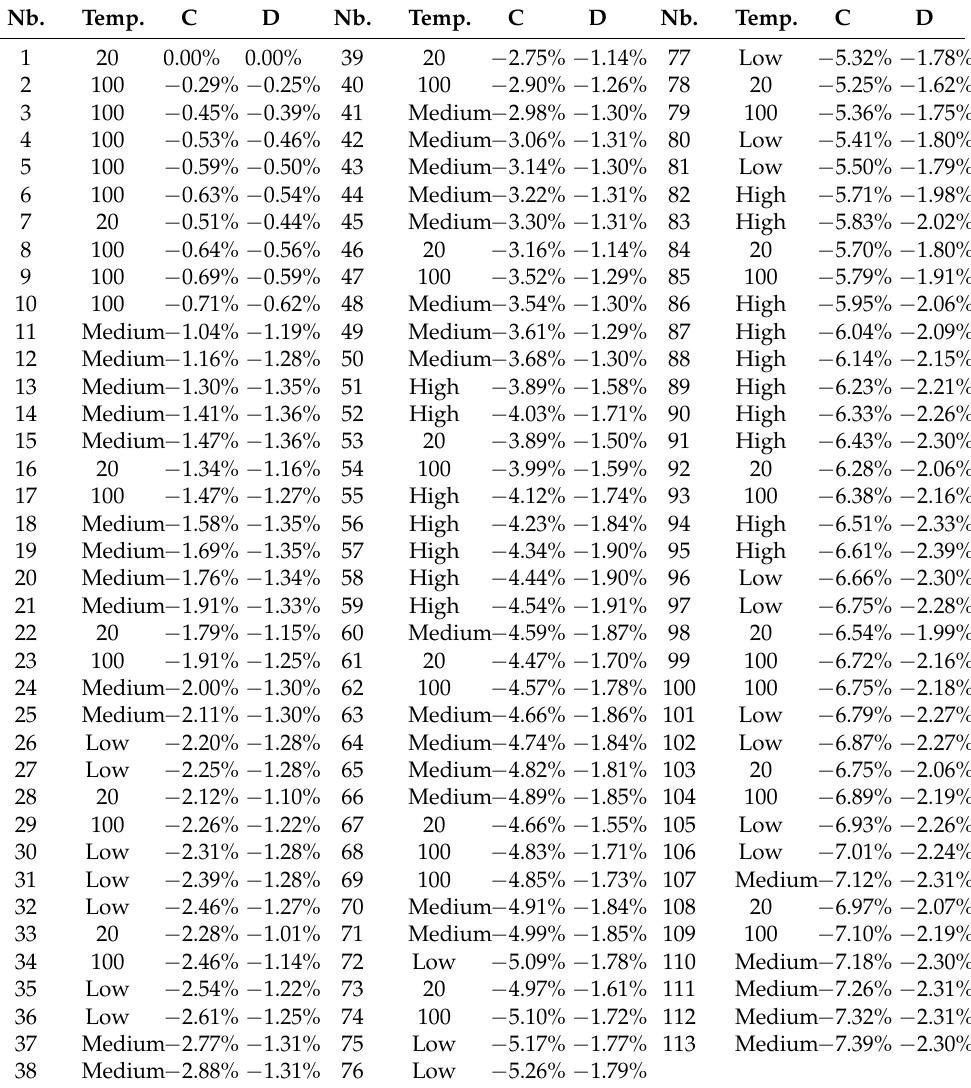
Table 1. Cumulative difference in mass for rig-tested Plate C and oven-dried Plate